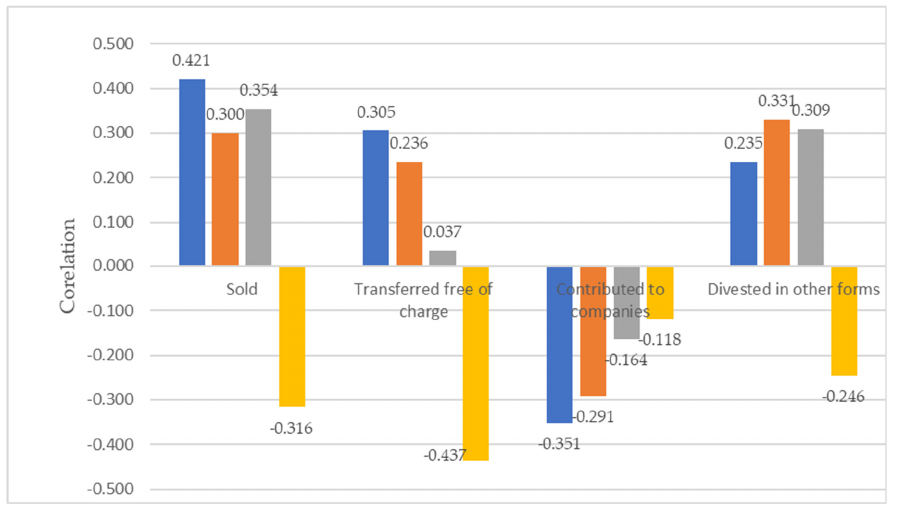
Figure 4. Correlation of the level of agricultural development determined by the Hellwig’s method with the NASC activities. Source: the authors. Since the agricultural level classes did not change between 2006 and 2018, the ranking of the voivodships in 2006, 2018, between 2006 and 2018, as well as changes in the ranking were based on raw "di" data. “Contribution to companies” always negatively correlated and the other NASC activities always positively correlated, except for the change in the ranking. “Contribution to companies” is the least active way of land management and, therefore, its impact on the level of agricultural development is not demonstrable. How- ever, the impact of the sale, lease or free transfer of land is visible. When the rankings are compared, it emerges that as the NASC activity increases, so does the level of agriculture in a given voivodship. However, while comparing changes in the rankings, the correlation proves to be in- versely proportional, which means that the NASC activities were conducted mainly in areas where the level of agriculture was the lowest. This proves that the measures were addressed mainly to the weakest voivodships and have been implemented consistently; therefore, the position in the rankings of voivodships where there is a large range of land transfer is improving. According to J. Guilford’s scale, the 2006 ranking was at level III, i.e., moderate correlation (significant dependence), except for paid transfers in other forms, where the correlations with the 2006 ranking reached level II, i.e., low correlation (clear relation). In the 2018 ranking with free contributions to companies, it is at level II,